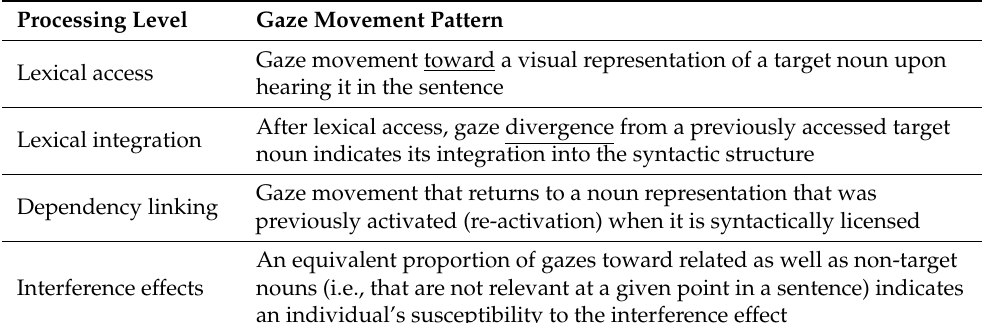
Table 1. Gaze movement metrics of specific sentence-level processes.